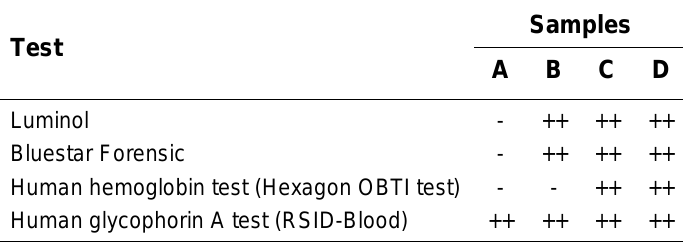
Results of Luminol, Bluestar Forensic, Human Hemoglobin, and Human Glycophorin A Tests on Bloodstains Washed